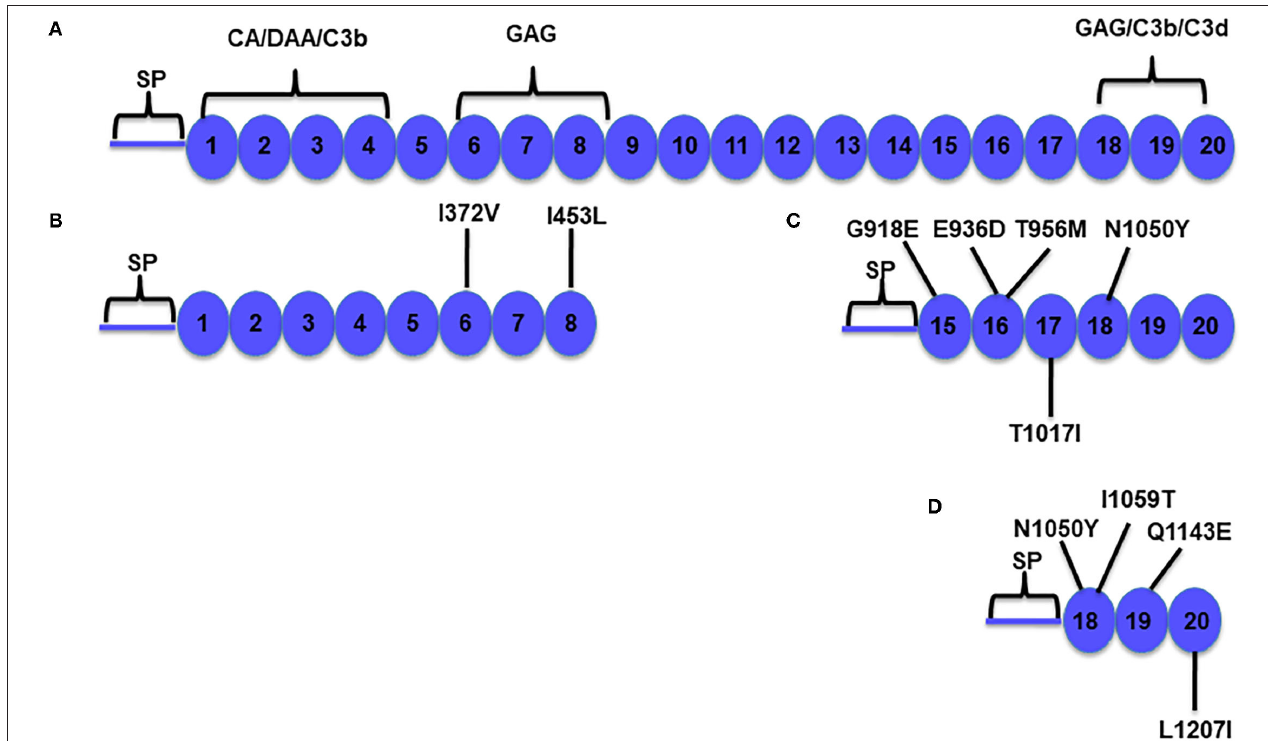
FIGURE 1 | Schematic diagram of Factor H (FH) and its functional domains. (A) Factor H is a 155-kDa plasma complement regulatory protein composed of 20 repeating homologous domains of approximately 60 amino acids each, known as complement control protein (CCP) repeats, short consensus repeats (SCRs), or sushi domains ( 12). Factor H prevents the formation and accelerates the decay of the alternative pathway C3 convertase (C3bBb; decay accelerating activity) and is a cofactor for Factor I-mediated cleavage and inactivation of C3b (cofactor activity). Factor H has fluid-phase and cell-surface regulatory capabilities (13). The N-terminal portion contains the regulatory domain that mediates the cofactor activity and decay accelerating activity (repeats 1–4). The surface binding recognition motifs are located in repeats 6–8 and 18–20. (B–D) Factor H constructs used to prepare the variants (as indicated). Residue numbering includes the 18 amino acids of the signal peptide (SP). CA, cofactor activity; DAA, decay accelerating activity; C3b, C3b binding site; C3d, C3d binding site; GAG, glycosaminoglycan binding